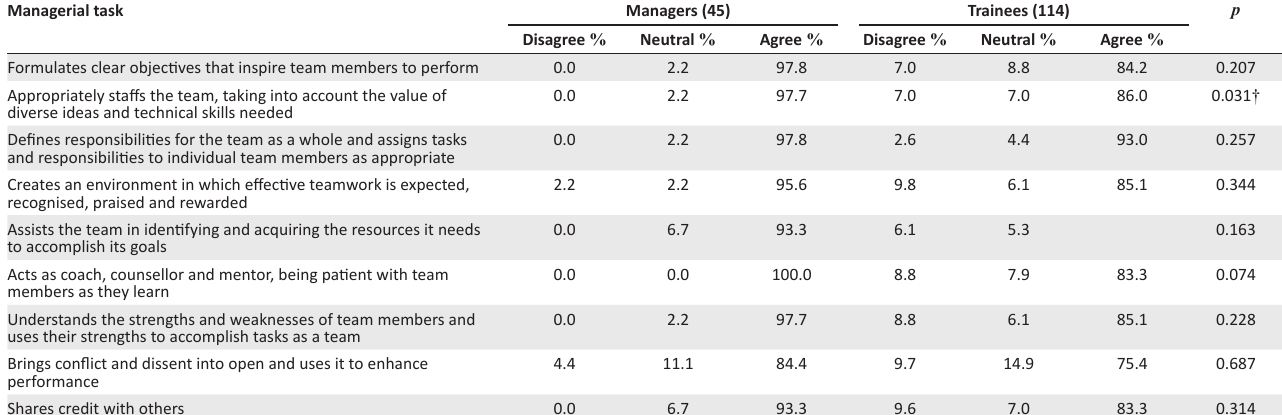
TABLE 6: Results for teamwork. Managerial task